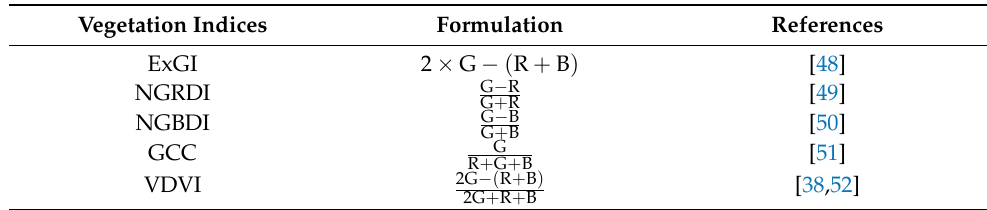
Table 2. The RGB-based spectral indices used in this study, where R, G, B represent the red, green, and blue band of the UAV Orthomosaic, respectively.